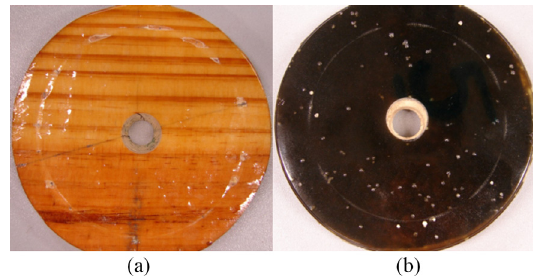
Figure 9. Images from the Pin-on-Disc Wear Test on samples coated with resin (a) and geotextile-resin (b). Table 2. Results from the pin-on-disc wear test. Sample Coating